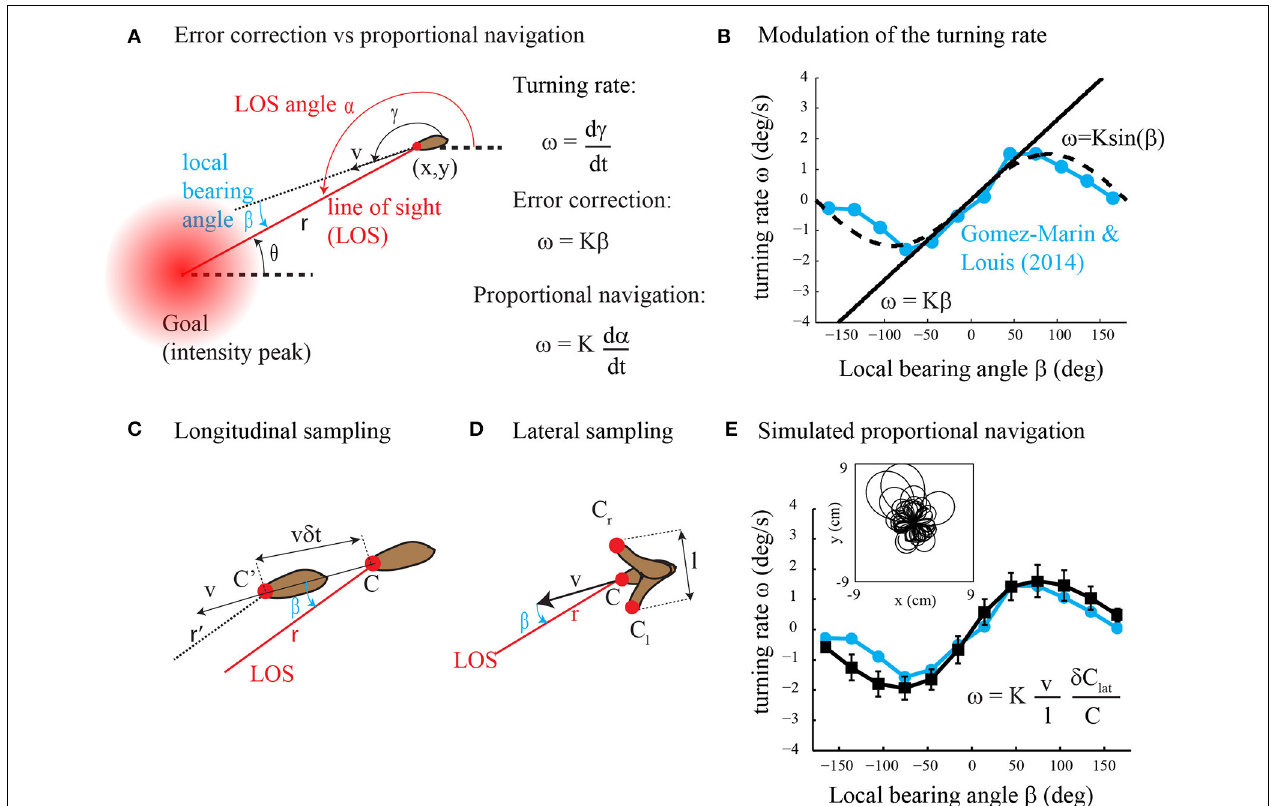
FIGURE 1 | (A) Error correction vs. proportional navigation. The turning rate is proportional to the local bearing angle in error correction and to the rate of change of the LOS angle in proportional navigation. See text for the details. (B) Dependency of the turning rate on the local bearing angle. The experimental data (in blue) are reprinted with modification from Figure 1C in Gomez-Marin and Louis (2014). The straight line represents error correction (Equation 2 with K = 1 . 5). The dashed curve is for ω = K sin β with K = 1 . 5. (C) Longitudinal sampling of the gradient along the direction of motion while the animal moves forward. See text for the details. (D) Lateral sampling of the gradient perpendicular to the direction of motion during head sweeps. See text for the details. (E) Dependency of the turning rate on the local bearing angle for simulated proportional navigation (black curve, mean ± s.d., n = 100 trajectories) as compared to experimental data (blue curve, same as in panel B ). The inset shows a